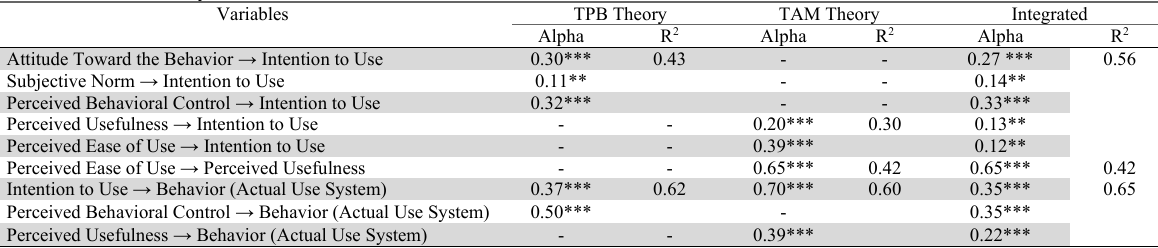
TPB and TAM Theory Test